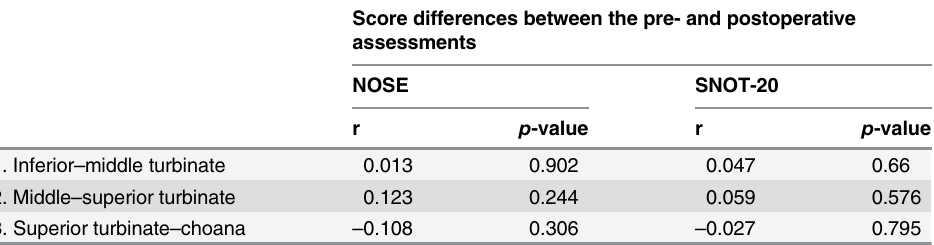
Table 4. Correlation between the NOSE and SNOT-20 and nasal cavity volume